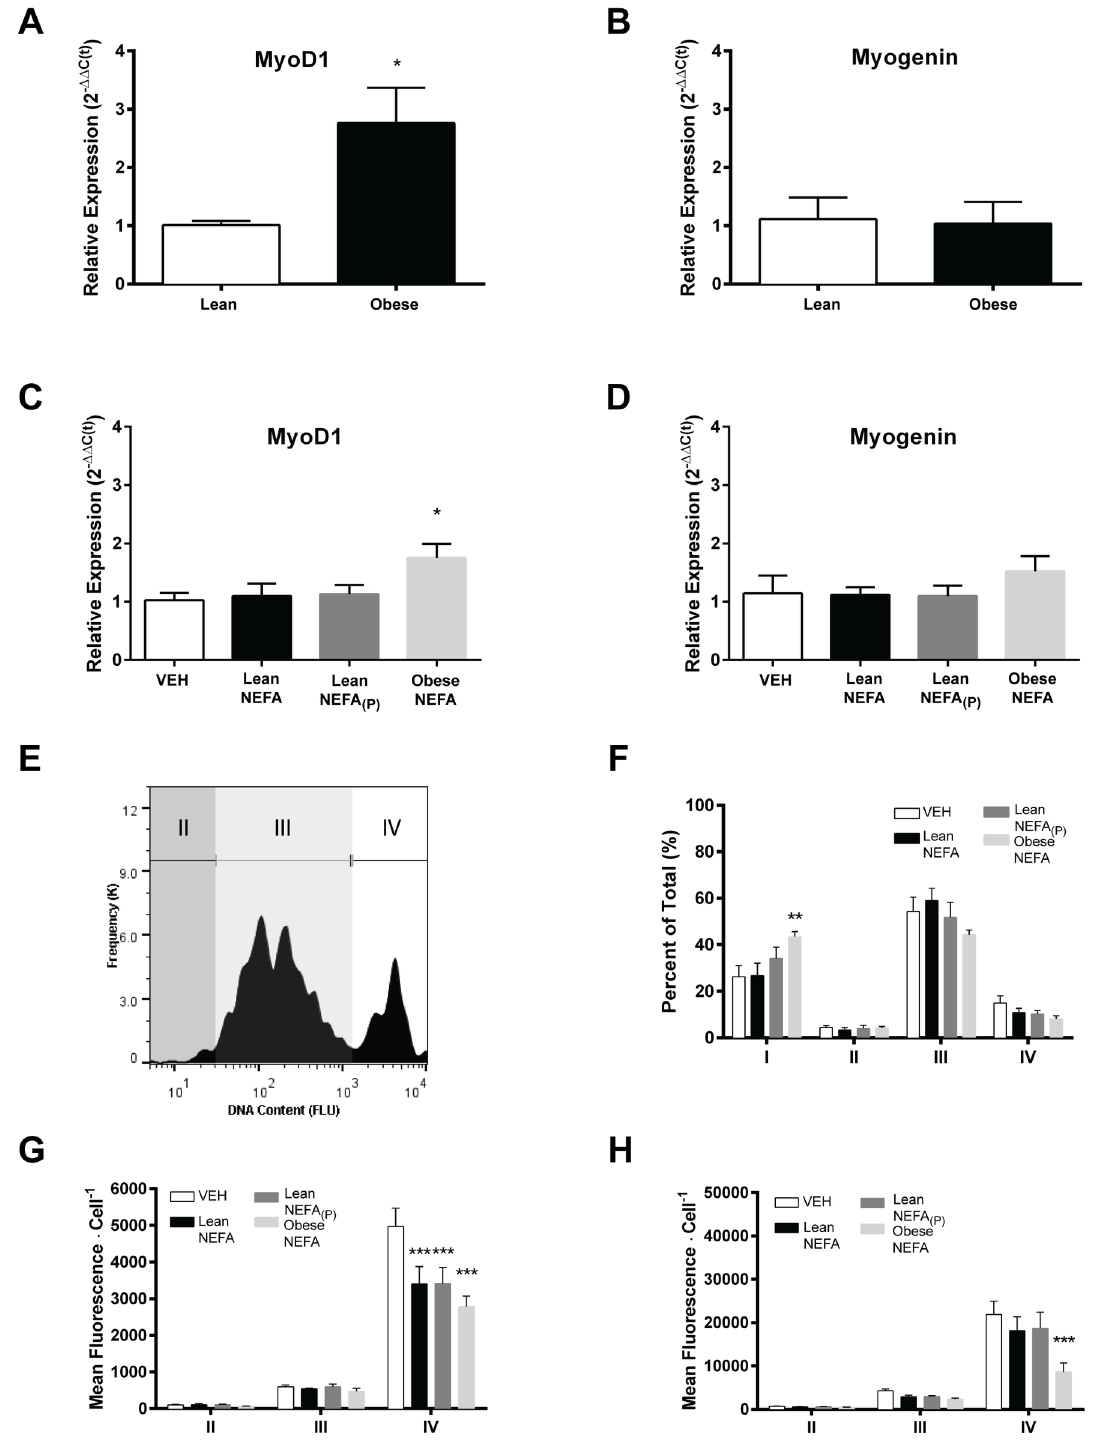
Fig 3. Assessment of growth and differentiation parameters suggest different responses between NEFA exposure groups. (A&C) MyoD1 mRNA was quantified as a marker of myoblast proliferation, and (B&D) myogenin mRNA was used as a marker of myotube differentiation in muscle biopsy or primary culture samples, respectively. (E) A modified fusion index was determined for each cell based on DNA content and categorized based on frequency clusters. (F) Percentages of cells identified in each fusion category were compared. Individual cell populations were analyzed for glucose uptake (G) and nascent protein synthesis (H). Data shown are means ± SE, n = 6 replicates/group, * P < 0.05, ** P < 0.01, and *** P < 0.001 by one-way ANOVA with Tukey ’ s posthoc or two-way ANOVA with Bonferroni ’ s posthoc